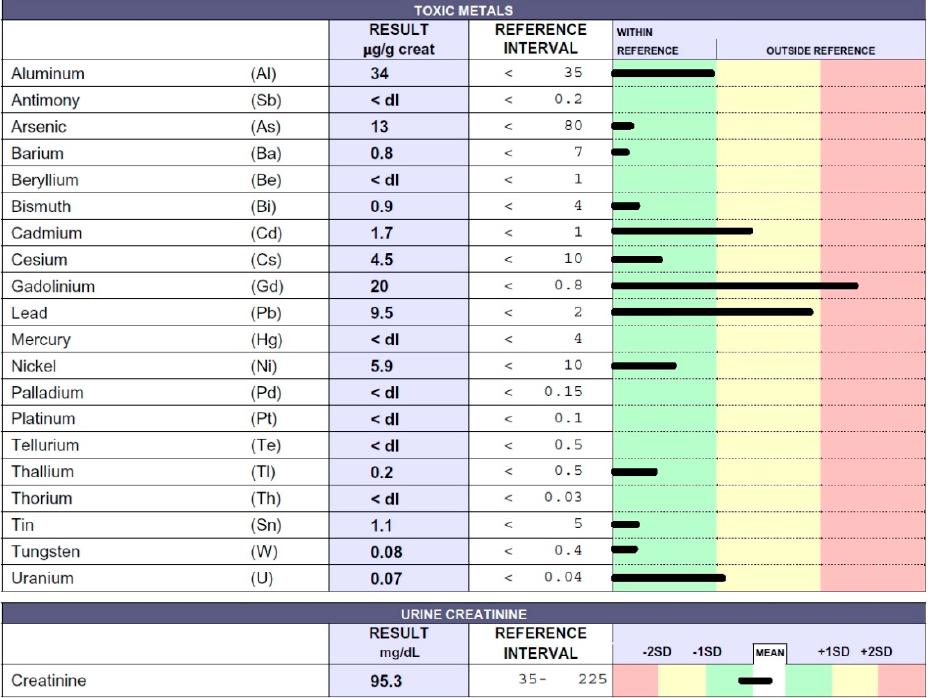
Figure 5. Toxic metal levels measured by ICP-MS method in the patient’s urine collected during the 12 h following EDTA chelation test reported in micrograms (µg) per g creatinine. The patient underwent chelation therapies with EDTA for a year and was affected by MS.